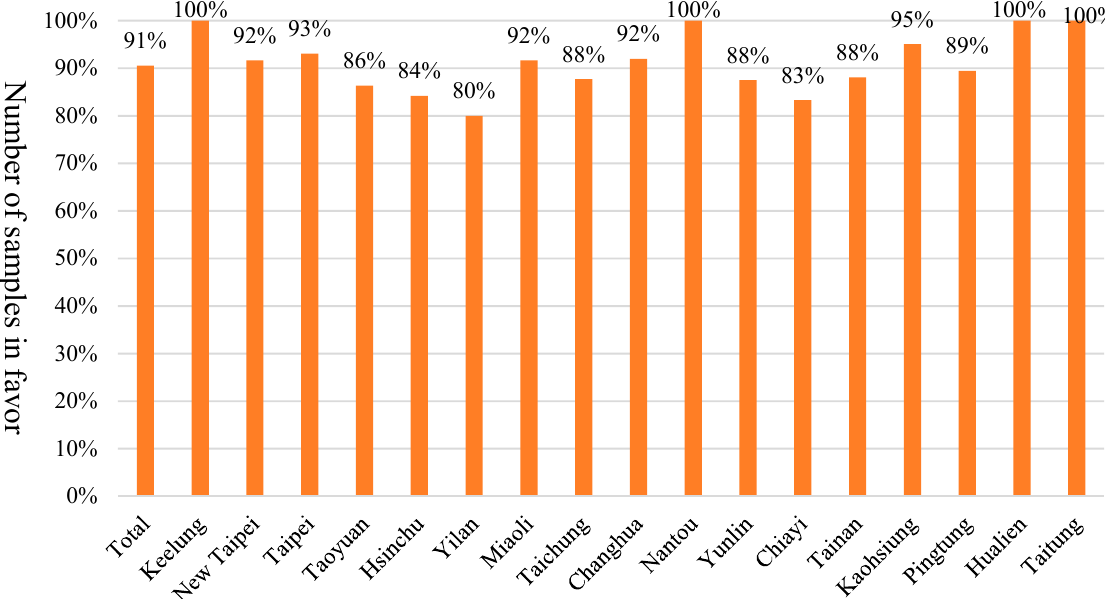
Figure 2. Supporting ratio of adaptation policies in response to climate change in each county/city in Taiwan (question 3).